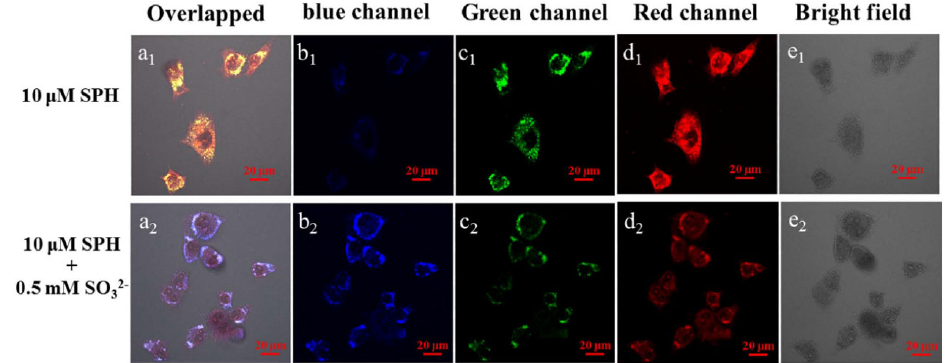
Figure 1. Fluorescence imaging of HeLa cells. Hela Cells incubated with 10 μ M probe 17 for 30 min ( a 1 – e 1 ) and pretreated with 0.5 mM Na 2 SO 3 for 30 min followed by incubation with 10 µ M probe 11 for another 30 min ( a 2 – e 2 ). ( a 1–2 ) merged of ( b 1–2 – e 1–2 ); ( b 1–2 ) blue channel; ( c 1–2 ) green channel; ( d 1–2 ) red channel; ( e 1–2 ) bright field; blue channel exited with a 404 nm laser; green and red channels excited with a 488 nm